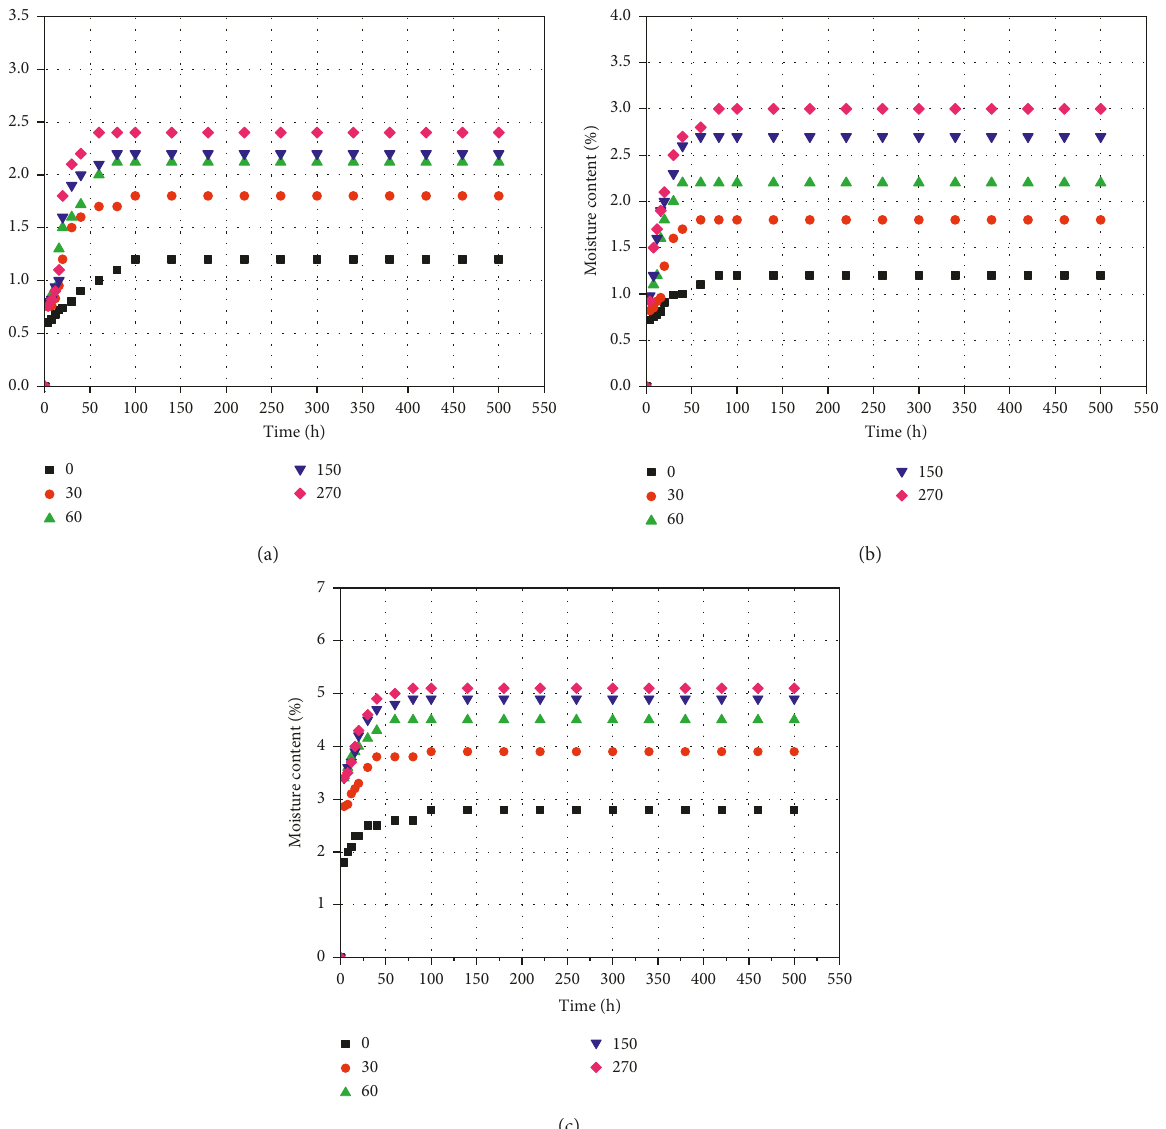
Figure 3: Moisture absorption curve at the temperature of 40 ° C at (a) RH 40%, (b) RH 60%, and (c) RH